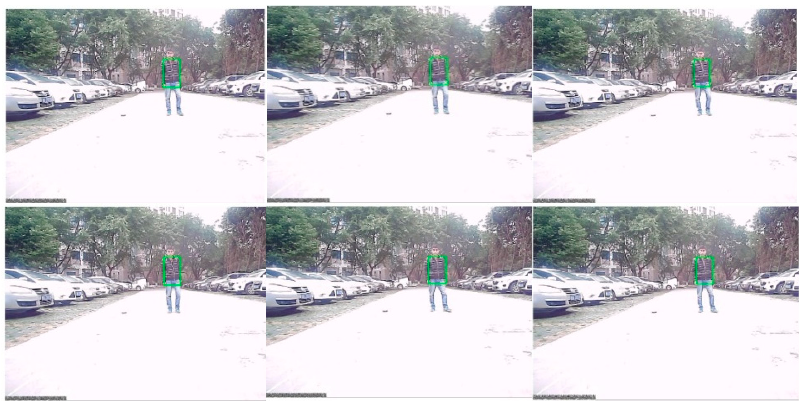
Figure 20. The results of object tracking based on a particle filter using low-rank representation.